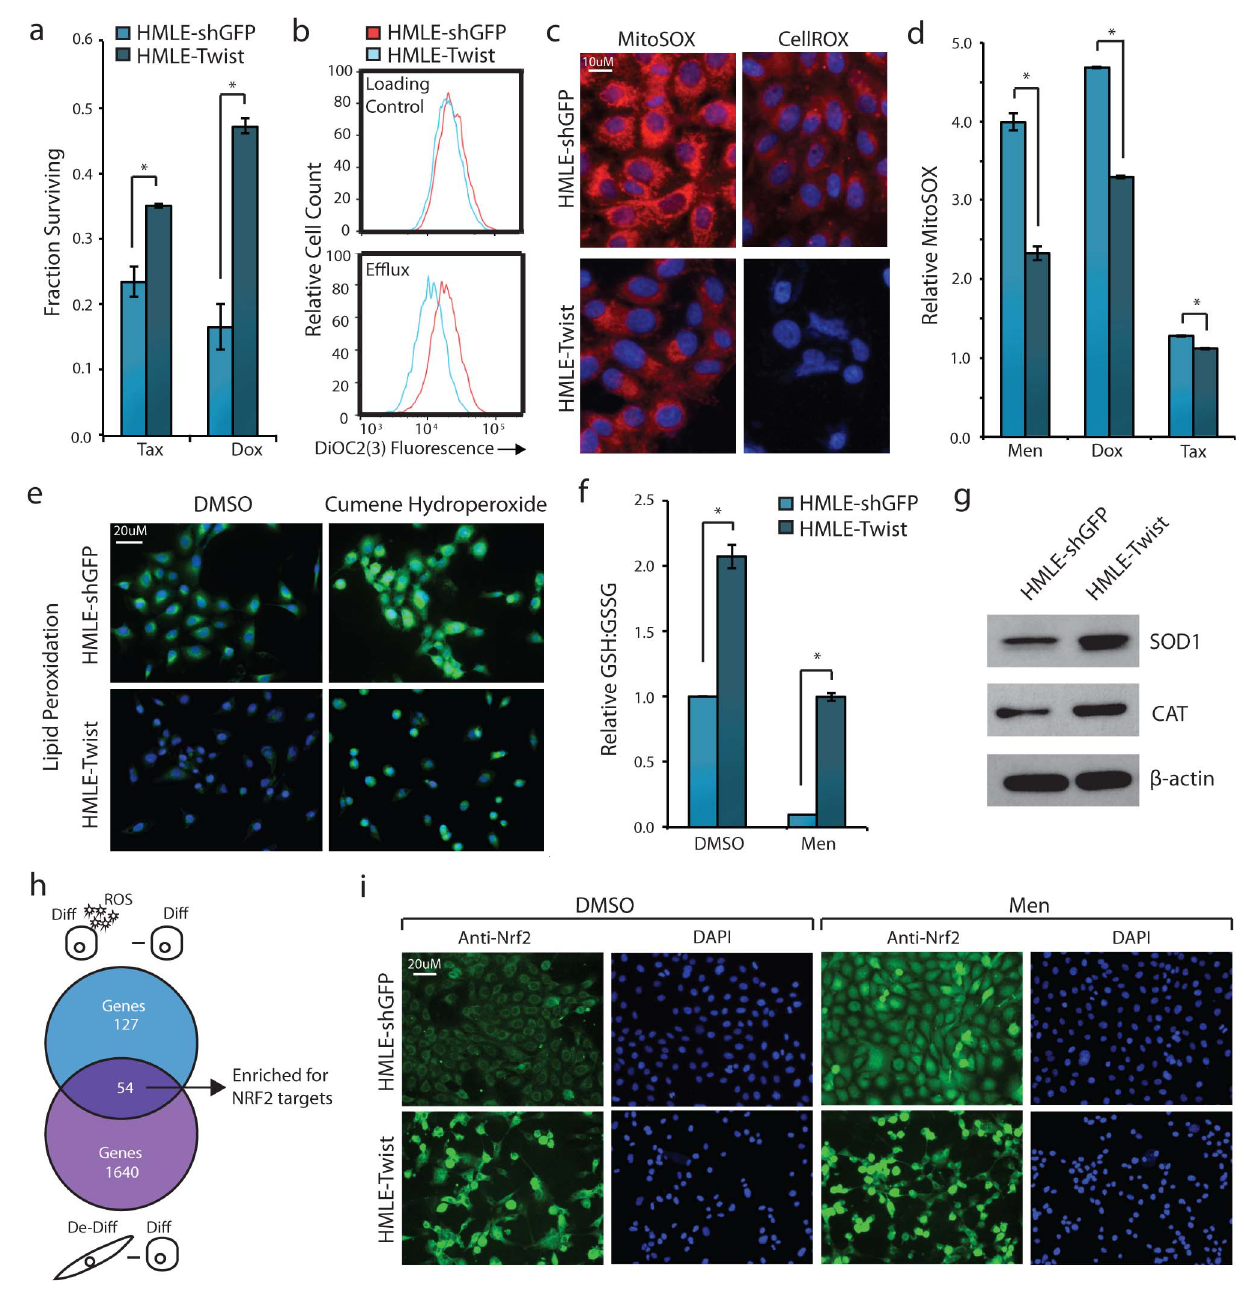
Figure 1. De-differentiated cells activate MDR and Nrf2 in the absence of oxidative or chemotherapy stress. (a) Fraction of HMLE- shGFP or HMLE-Twist cells surviving 3-d treatment with 2 nM Tax or 30 nM Dox, normalized to individual vehicle-treated controls. (b) Flow cytometry quantification of MDR1-mediated efflux ability. HMLE-shGFP or HMLE-Twist cells were loaded with cell-permeable DiOC2(3)-dye and efflux ability measured by loss of fluorescent signal after 1.5 h (efflux) compared to the loading control. (c) Fluorescent microscopy images of relative cellular ROS levels using the mitochondrial superoxide (MitoSOX) probe (red channel) or general oxidative stress (CellROX) probe (red channel) and cell nuclei labeled with DAPI (blue channel). (d) Flow cytometry quantification of MitoSOX fluorescence relative to individual vehicle-treated controls. Cells were treated with 40 m M menadione, 1 m M Dox, 1 m M Tax, or DMSO for 2 h prior to analysis. (e) Fluorescent microscopy images of relative lipid peroxidation levels (green channel) and cell nuclei labeled with DAPI (blue channel). Indicated cells were treated with 100 m M cumene hydroperoxide or DMSO for 2 h prior to analysis. (f) Relative amounts of reduced (GSH) to oxidized (GSSG) glutathione measured by luminescence-based assay. Indicated cells were treated with 40 m M menadione or DMSO for 2 h prior to analysis. Each sample is normalized to HMLE-shGFP DMSO control. (g) Western blot analysis of SOD1, CAT, and b -actin. (h) Overlap of genes . 2-fold up-regulated in differentiated cells treated with 40 m M menadione (ROS) for 2 h compared to corresponding DMSO control (blue circle), and de-differentiated cells compared to differentiated cells in the absence of treatment (purple circle). (i) Immunofluorescence microscopy images of Nrf2 localization upon treatment with 40 m M menadione or DMSO for 2 h. Nrf2 protein was indirectly labeled with a secondary Alexa Fluor 488 antibody (green channel) and cell nuclei labeled with DAPI (blue channel). * p , 0.05. Data are presented as mean 6 SEM.